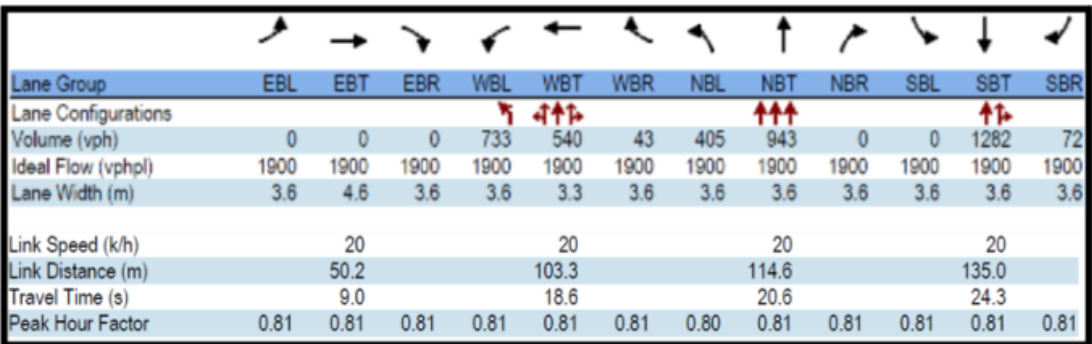
Figure 12: Traffic flow variables and lane configuration abstract estimated by Synchro for Intersection